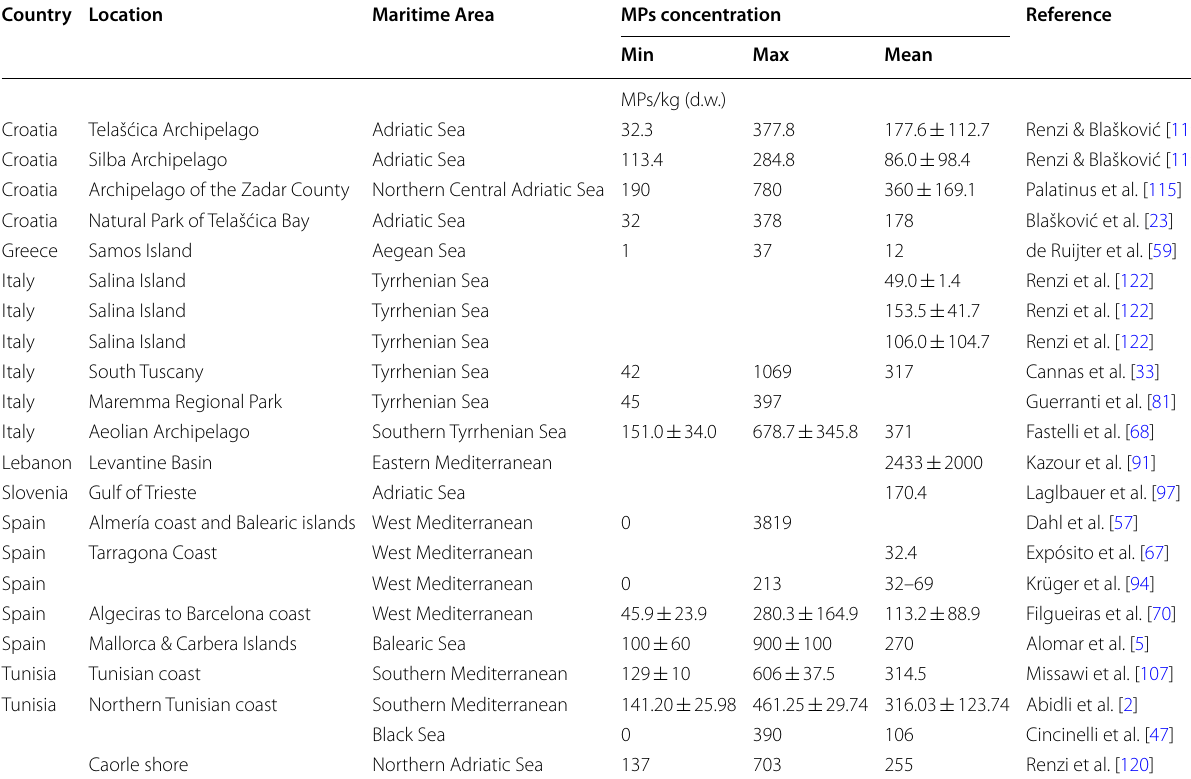
Table 6 A summary of the number of MPs found in marine sediments around the Mediterranean basin (items per kg dry